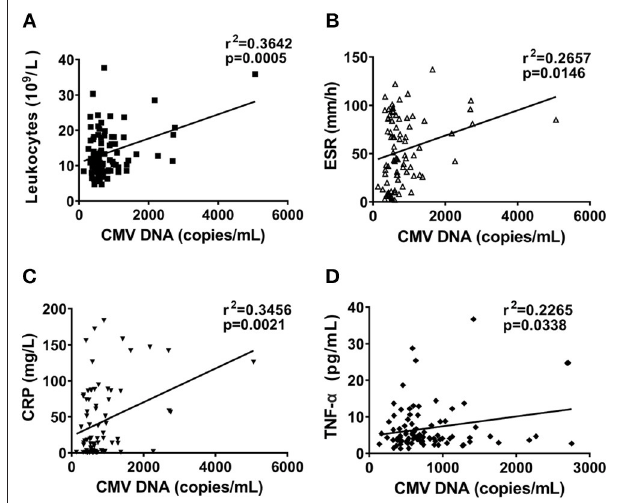
FIGURE 5 | Correlation between CMV DNA copy number and inflammatory index in AOSD patients. Correlation between CMV DNA copy number and leukocytes (A) , ESR (B) , and CRP (C) , and TNF- α levels (D) . The correlations were evaluated with Spearman’s non-parametric test. p < 0.05 represents a significant